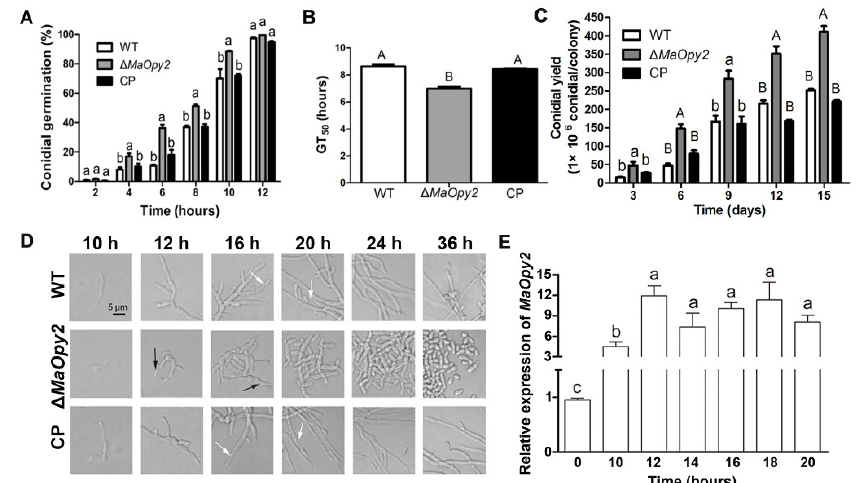
Figure 8. Deletion of MaOpy2 increases the conidial yield by shifting the conidiation pattern. ( A ) Conidial germination of fungal strains on a 1/4 SDAY medium. ( B ) Half germination time (GT 50 ) of fungal strains. ( C ) Conidial yield of fungal strains on a 1/4 SDAY medium. ( D ) Deletion of MaOpy2 shifts the conidiation pattern. Microscopic observation of the conidiation pattern of each strain grown on 1/4 SDAY for different times; white arrows and black arrows represent normal conidiation and microcirculation conidiation, respectively. ( E ) Expression levels of MaOpy2 at different time points. A & B and a & b & c presented the significant difference at p < 0.01 and p < 0.05,